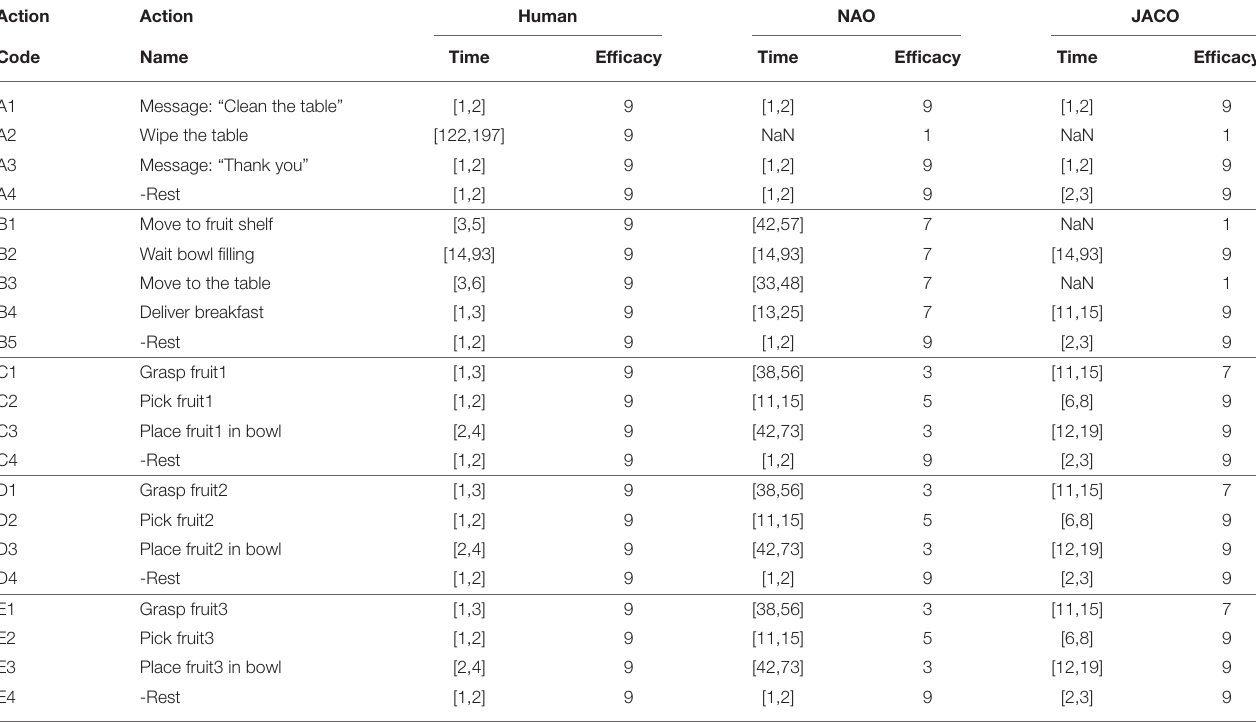
TABLE 3 | Agents’ time and error level for each action. Action Action Human NAO JACO